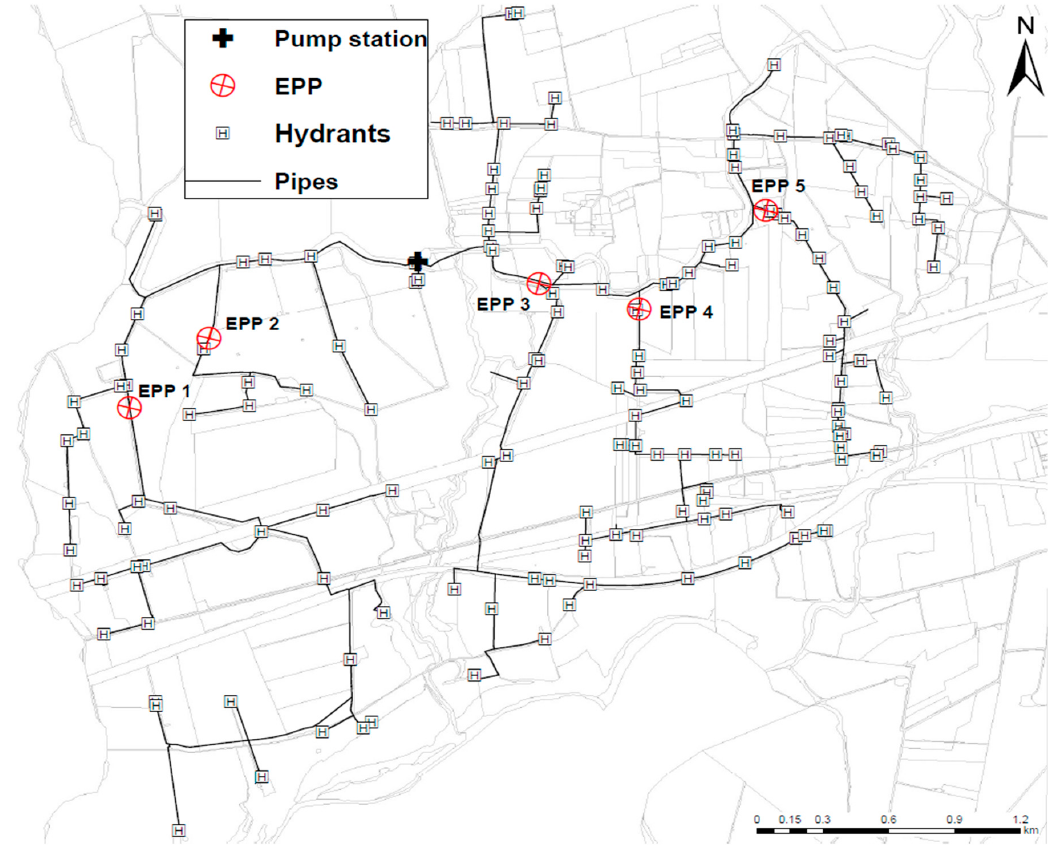
Figure 5. EPPs in the sector VII of the right bank of the Bembezar River irrigation district.